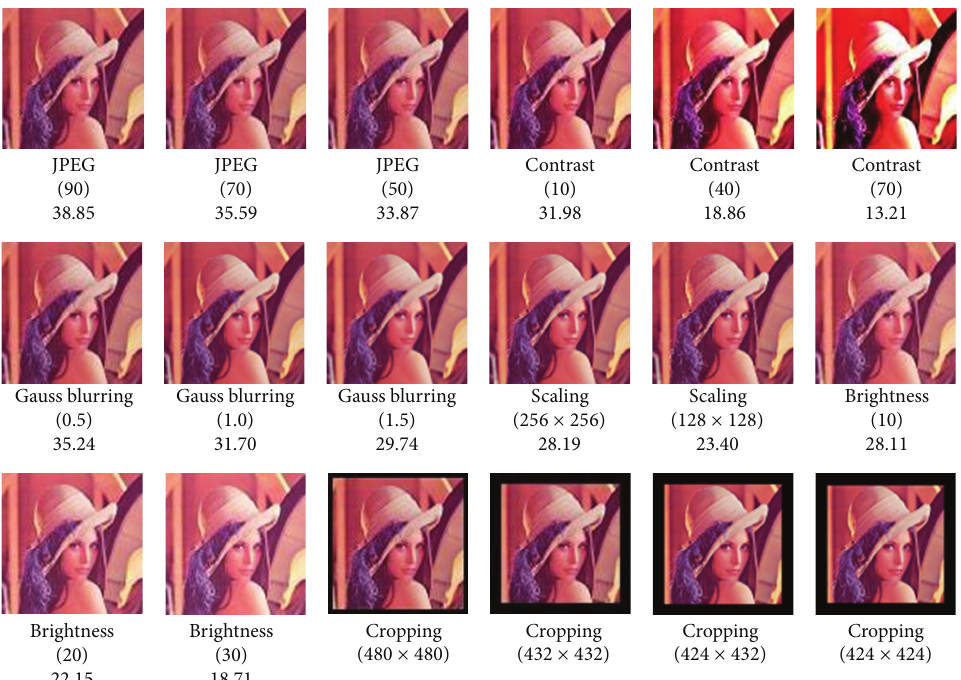
Figure 13: Some examples of ”Lena” after different image attacks (PSNRs are listed in the last rows).